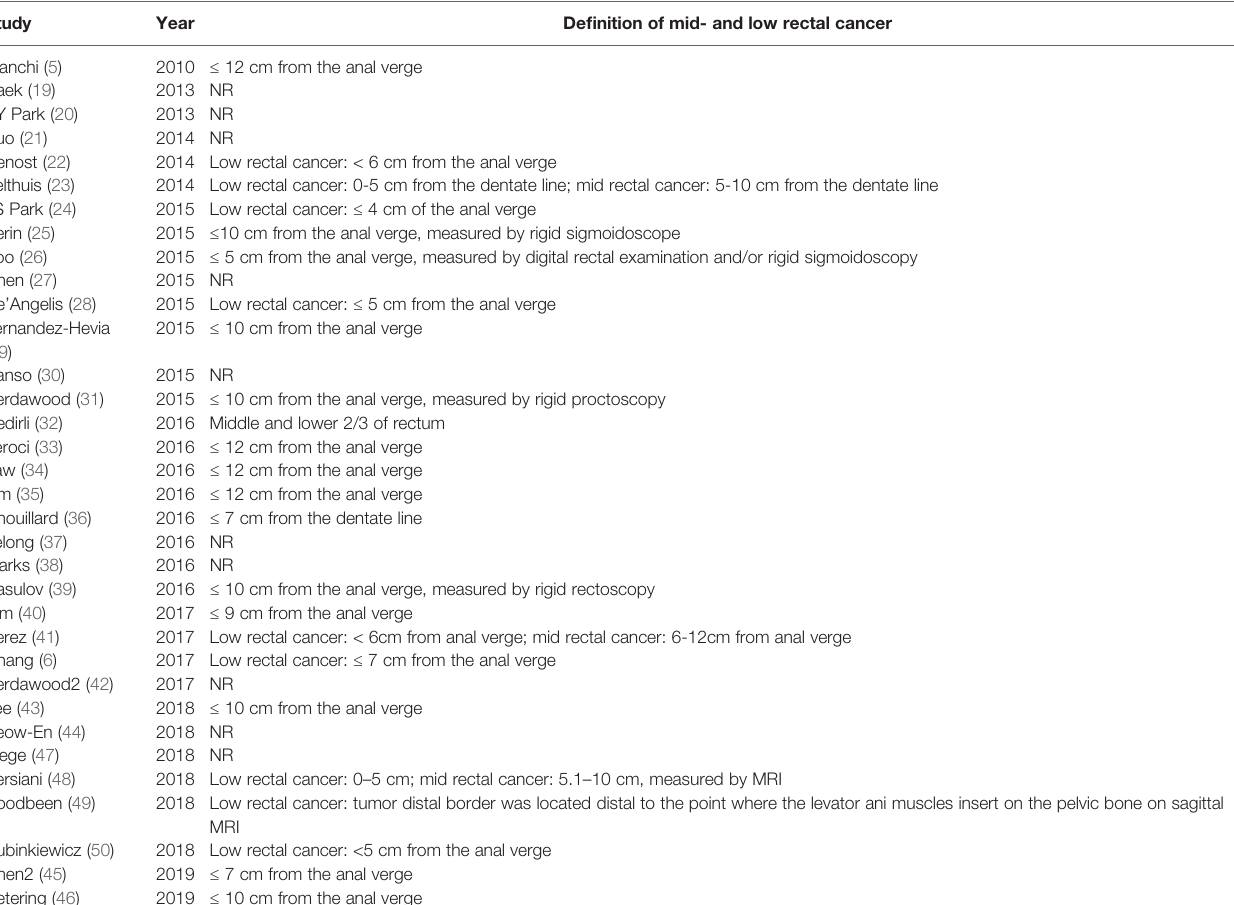
TABLE 2 | De fi nition of mid-/low rectal cancer in included